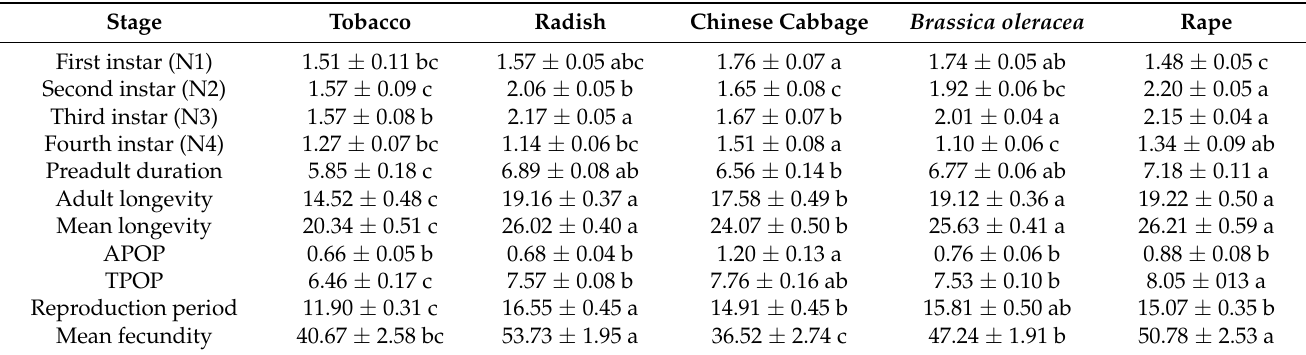
Table 3. Preadult duration, adult longevity, mean longevity, reproduction period, and mean fecundity of M. persicae on five host